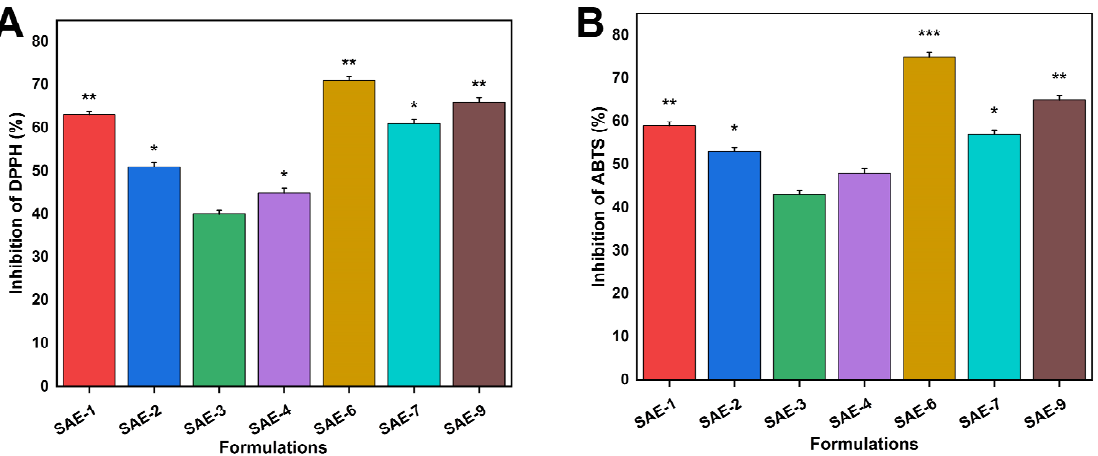
Figure 10. Antioxidation effect of SA-g-AMPS hydrogels against DPPH ( A ) and ABTS ( B ). Here, * shows the p value < 0.05, ** p < 0.01, and *** p < 0.001.